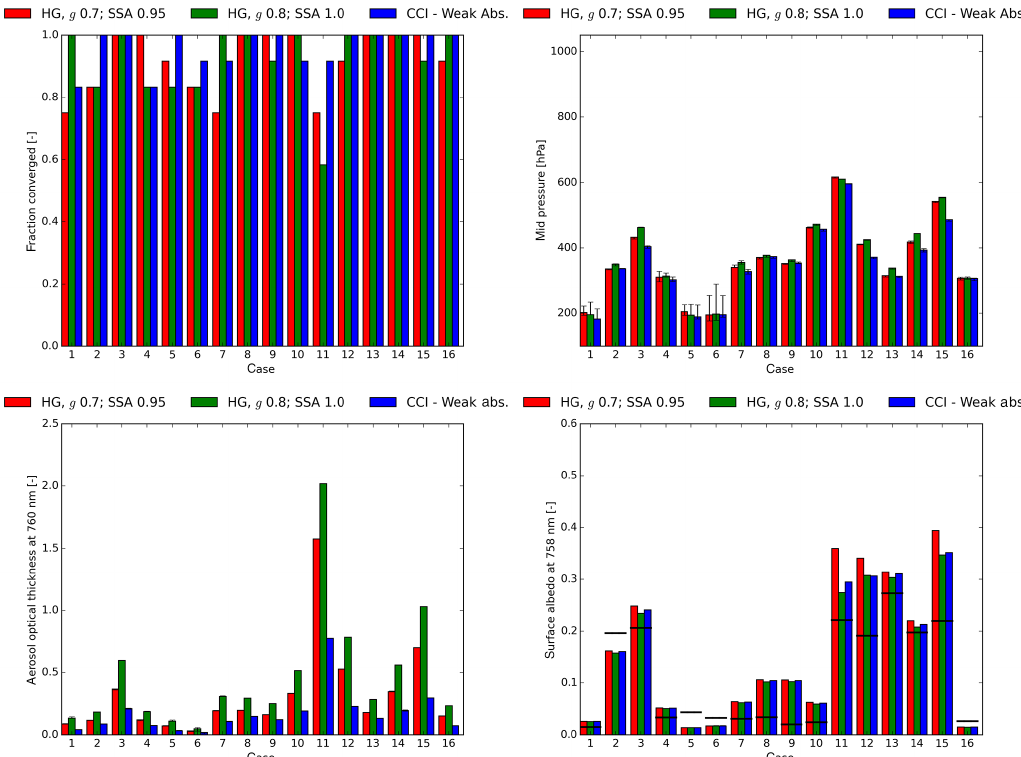
Figure 9. Fraction of converged runs (top left), retrieved aerosol layer mid pressure (top right), retrieved aerosol optical thickness (bottom left) and retrieved surface albedo at 758nm (bottom right) for 16 GOME-2A target pixels and three different aerosol models. For a description of these aerosol models, see the main text. The first aerosol model is the model also assumed in the scene retrievals. All other details of the retrieval setup are the same as in Sect. 7 and the surface albedo is fitted (as in Fig. 7). Thus, retrieval results for cases 01, 03 and 04 shown here with red bars are the same as retrieval results for highlighted target pixels in the scenes of Fig. 7. Also, retrieval is now attempted for 12 different sets of initial values (as opposed to six in the scene retrievals). Whiskers for retrieved parameter values indicate the maximum to minimum range of retrieval solutions. Often, the range of retrieval solutions for different initial values is so small that whiskers are not visible. Finally, black horizontal line segments in the bar plot for the surface albedo show the climatological (a priori) value from the MERIS black-sky albedo